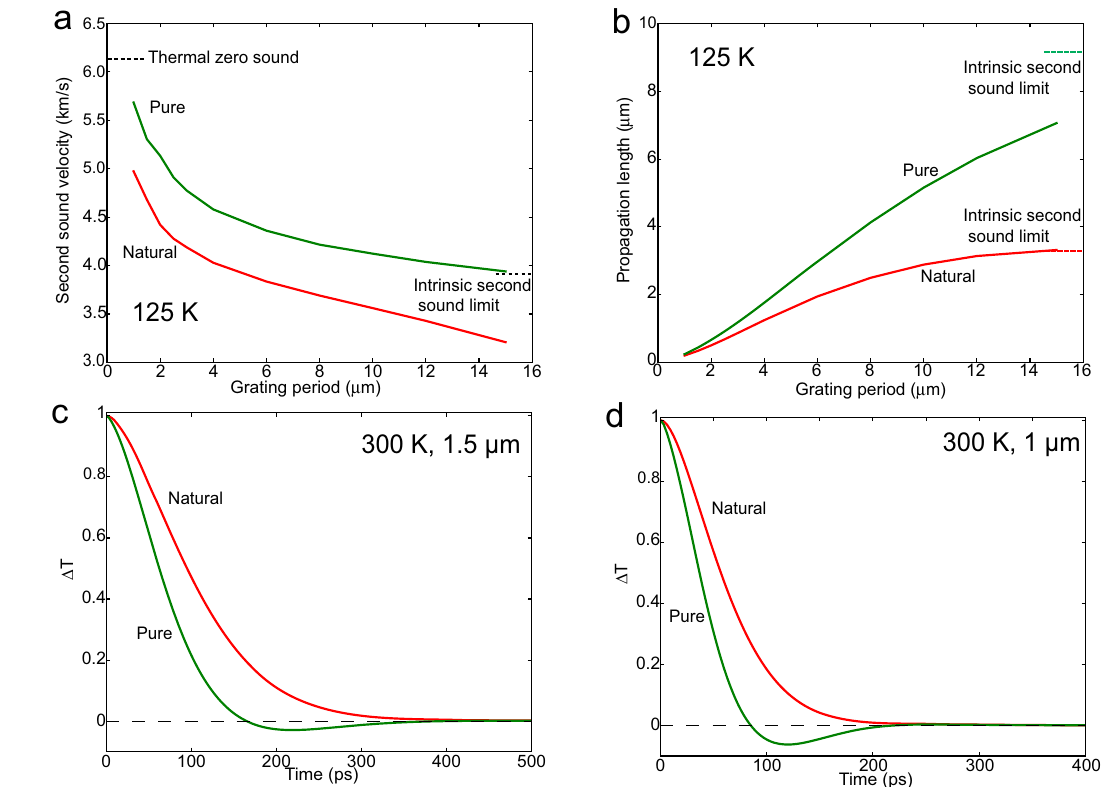
Fig. 4 Isotope effect on second sound. Variation of ( a ) second sound velocity and ( b ) propagation length with grating period at 125 K in natural and isotopically pure graphite. c Calculated TTG signals at 300 K with a grating period of 1.5 μ m and ( d ) 1 μ m